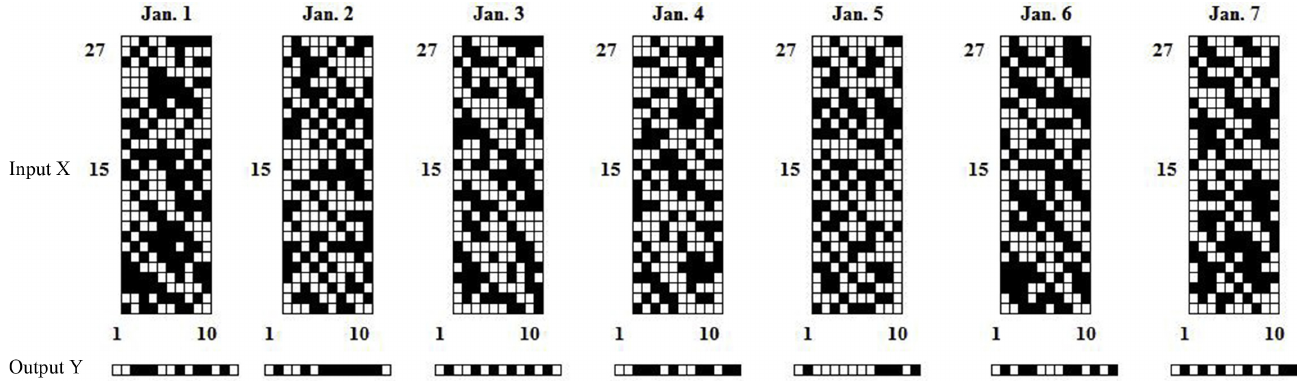
Fig 3. Inputs (in binary 27 × 10 image format) and outputs (in binary 1 × 14 image format) for forecasting the load at 1:00 from Jan. 1 to Jan. 7, 2004, for Zone 1. The black-and-white images in the top row are the inputs for the CNN modelling. These digital images represent binary matrices (27 × 10) that are converted from 270-bit input vectors in Fig 2. The images on the bottom row that resemble black-and-white bar codes comprise the output from the CNN and represent load output predictions in the form of 14-bit binary vectors.